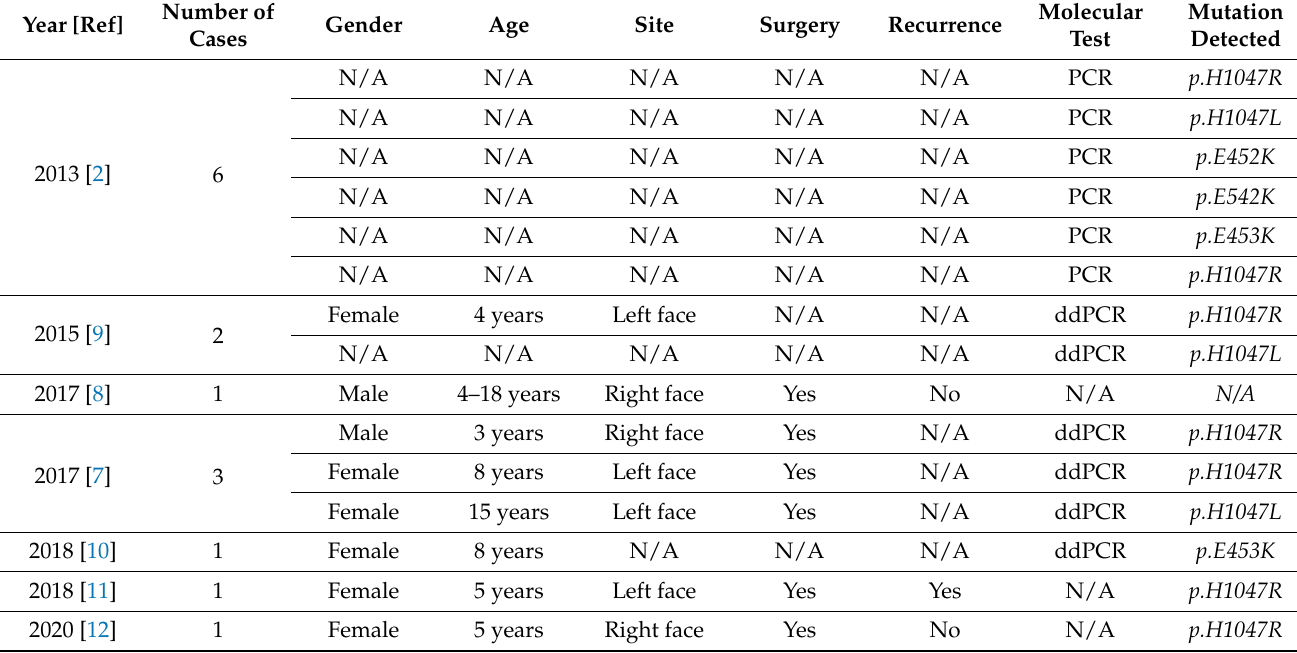
Table 1. Review of select congenital infiltrating facial lipomatosis cases with confirmed PIK3CA